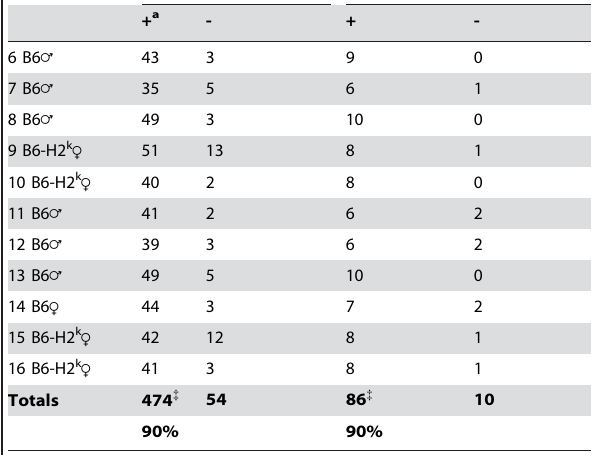
Table 2. Responses to urine odor choices for Behavior Experiment